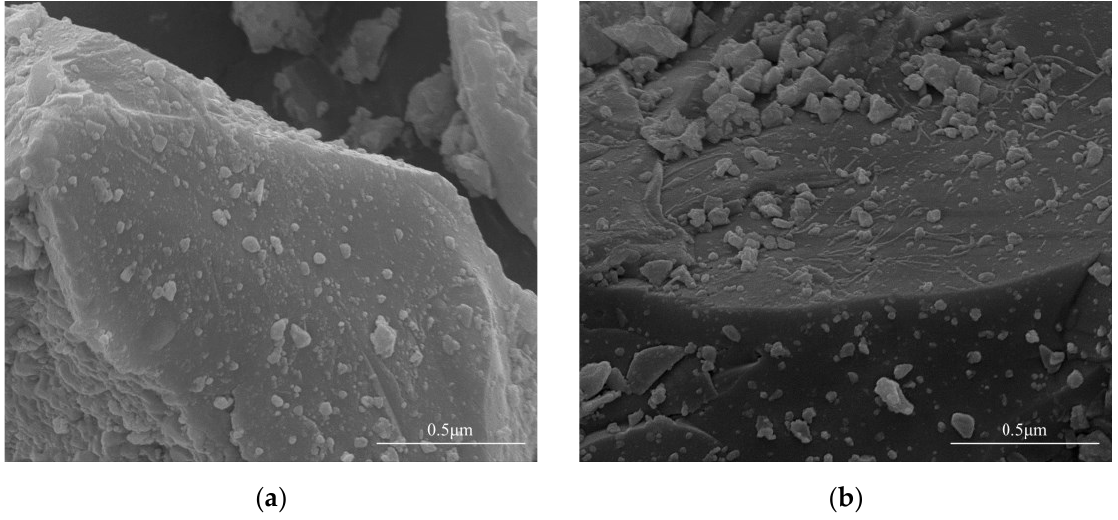
Figure 5. The microstructures of ( a ) clinker without pretreatment and ( b ) pretreated